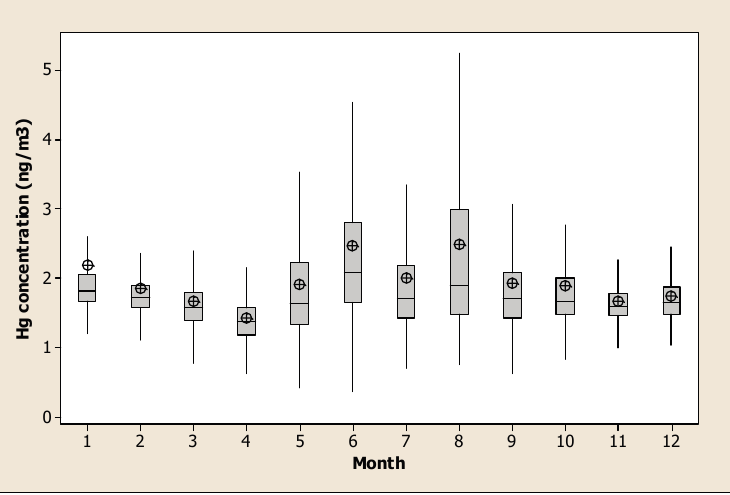
Figure 2. Monthly TGM concentrations during 2007–2011 in